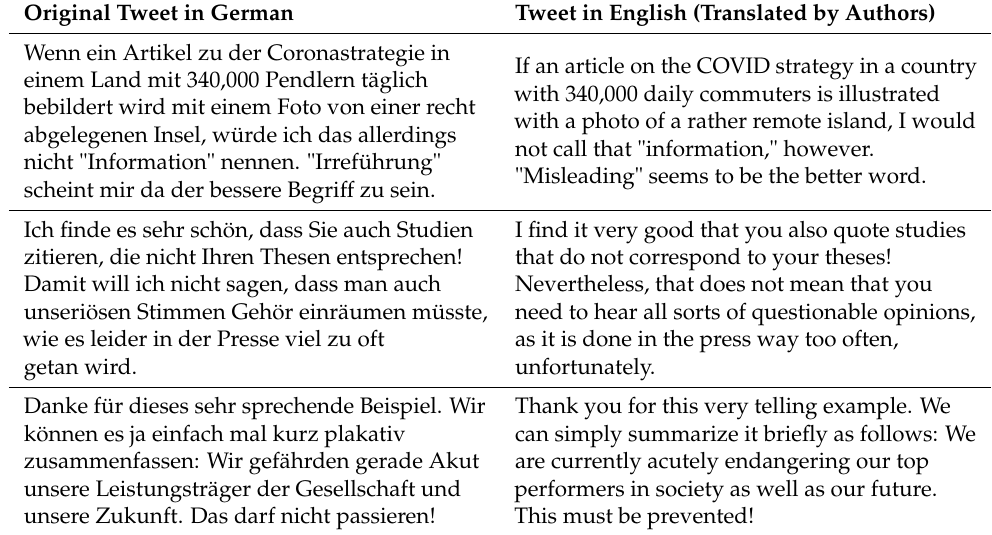
Table 4. Examples tweets related to science